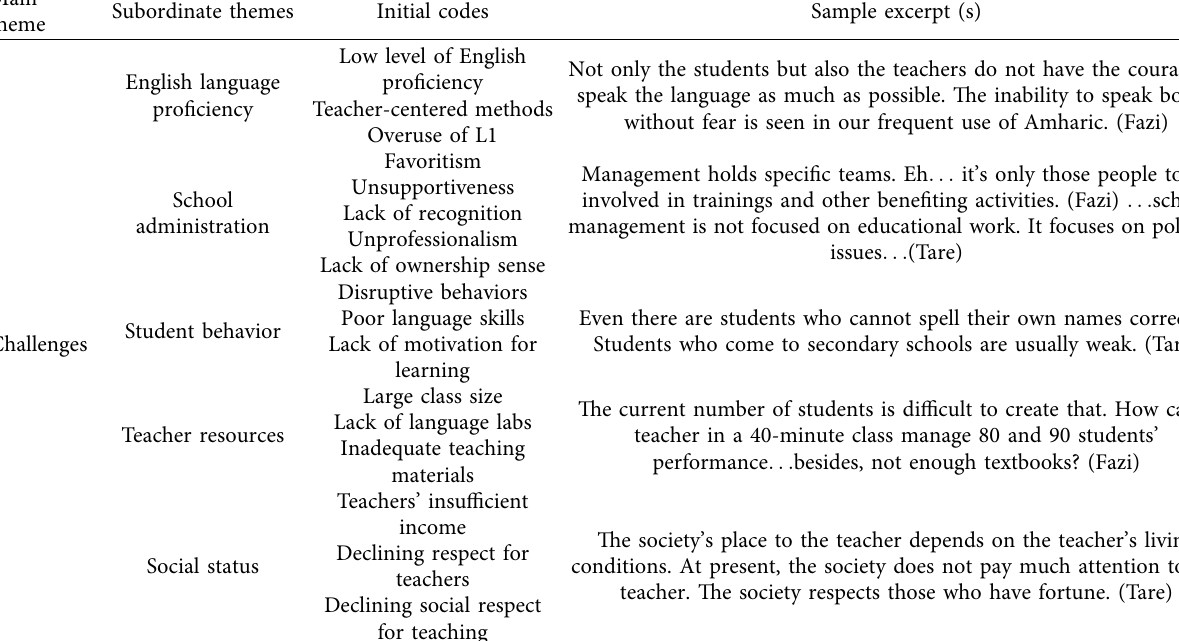
Table 1: Perceived challenges to the development of professional